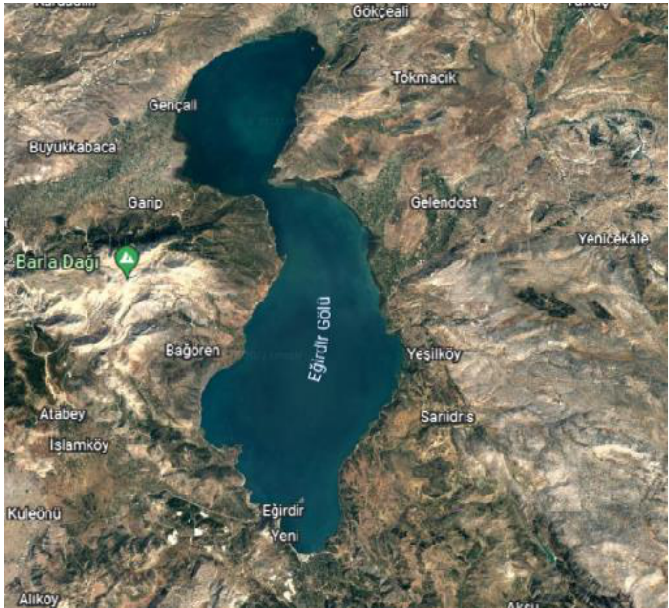
Figure 1. Map of Lake Eğirdir.